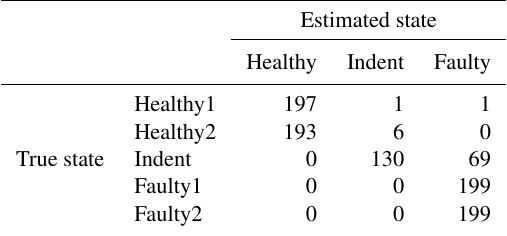
Table 14. Confusion matrix for 1500rpm MEMS data and the top four features, classifier trained with ramp-up data, with an addi- tional offset in the steady-state validation data.